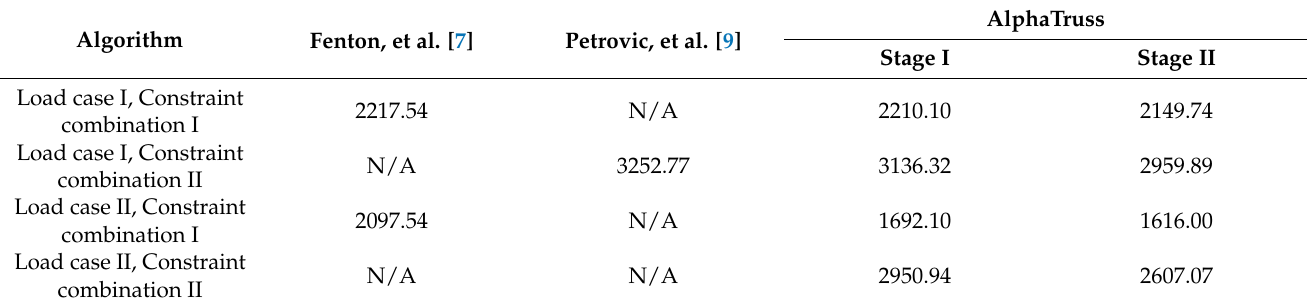
Table 6. Experiment 2 results: minimum truss weights